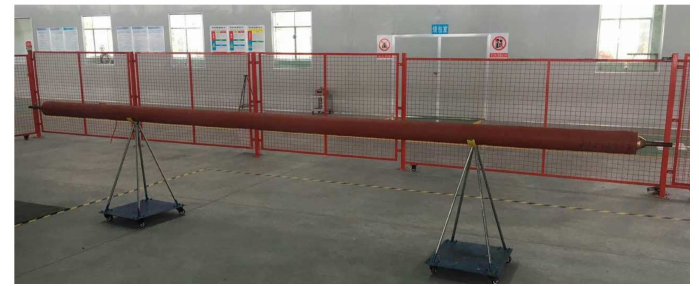
Figure 11. Prototype of a 35-kV PCC cable